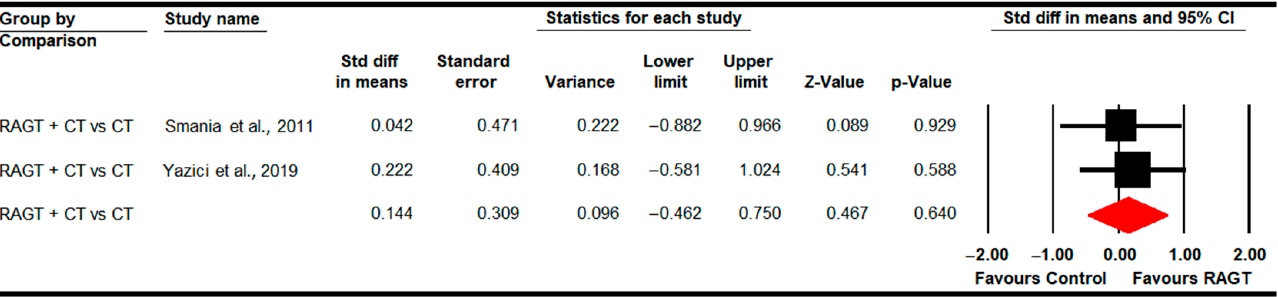
Figure 10. Forest Plot of Total Gross Motor Function (Post-Intervention Assessment) [83,87,89–91].